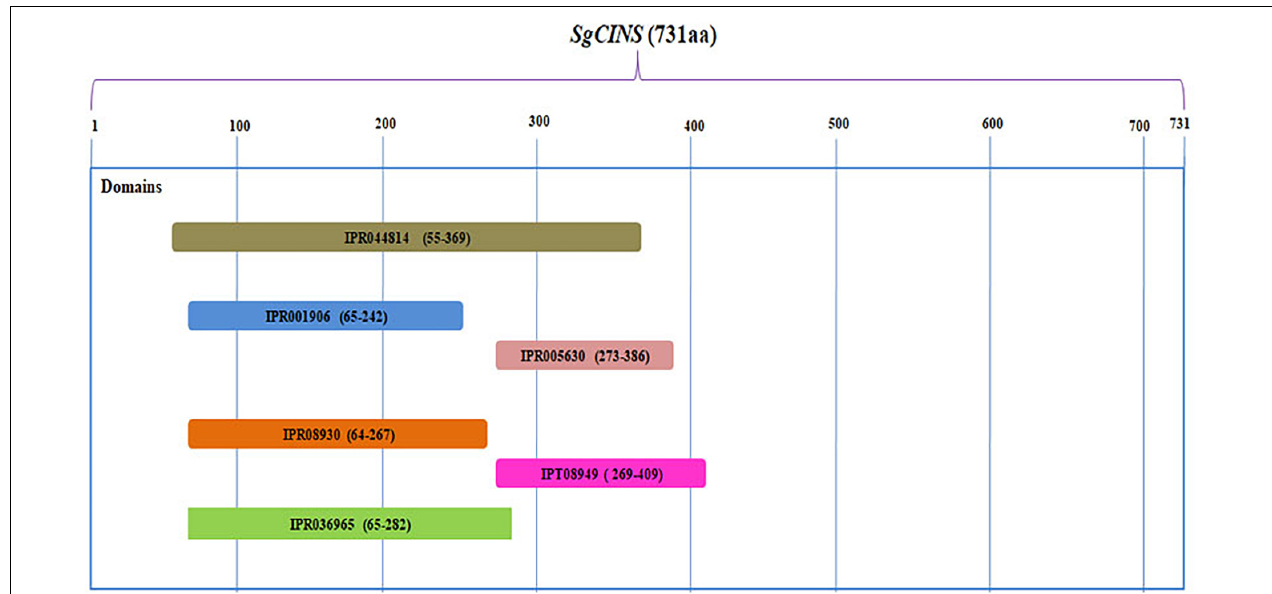
FIGURE 2 | The putative domains structure for SgCINS gene. Six putative domains were detected in SgCINS at different amino acids positions such as, terpene cyclases, class 1, plant (IPR044814); terpene synthase, N-terminal domain (IPR001906); terpene synthase, metal-binding domain (IPR005630); terpenoid